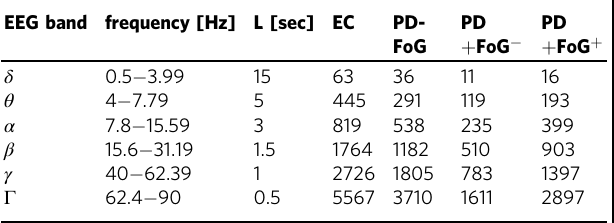
Table 1 EEG frequency bands and number of analyzed segments for each group and frequency